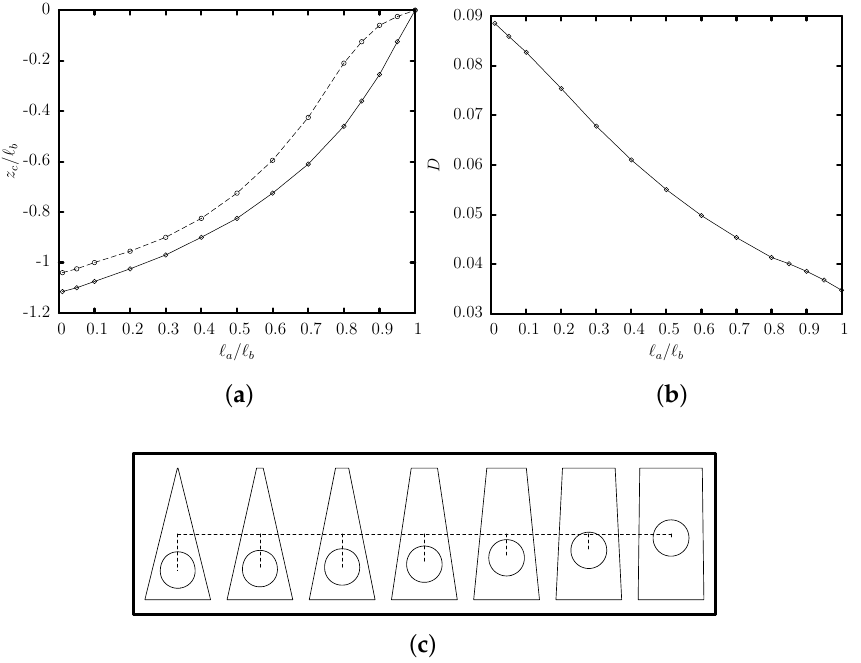
Figure 8. Steady-state variation with the base ratio (cid:96) a / (cid:96) b of ( a ) the centroid z c and ( b ) the deformation D , for a capsule with a / (cid:96) b = 0.55 and Ca = 0.1 flowing in a trapezoidal channel with height (cid:96) z / (cid:96) b = 2. In ( a ) also included is the location of the maximum inlet velocity u x (---). ( c ) The steady-state side profile (i.e., intersection of the system surface with the plane x = x c ) for channel’s base ratio (cid:96) a / (cid:96) b =